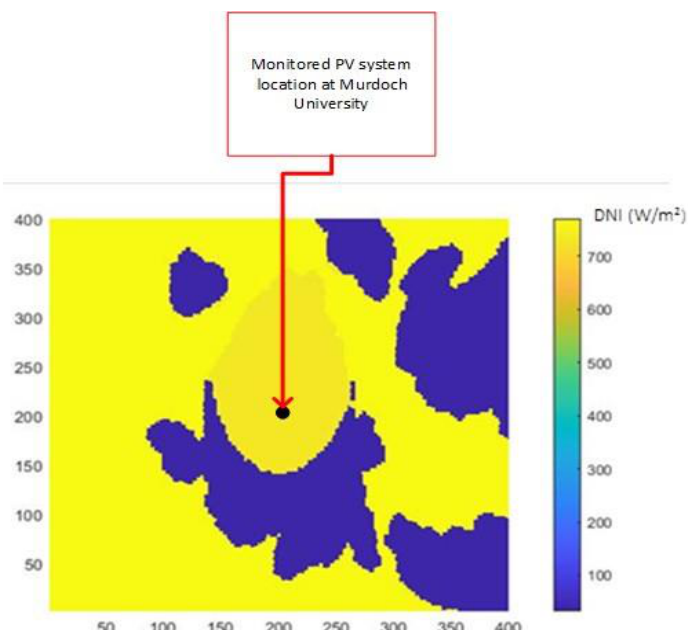
Figure 9. A two-dimensional exemplary nowcast DNI map.